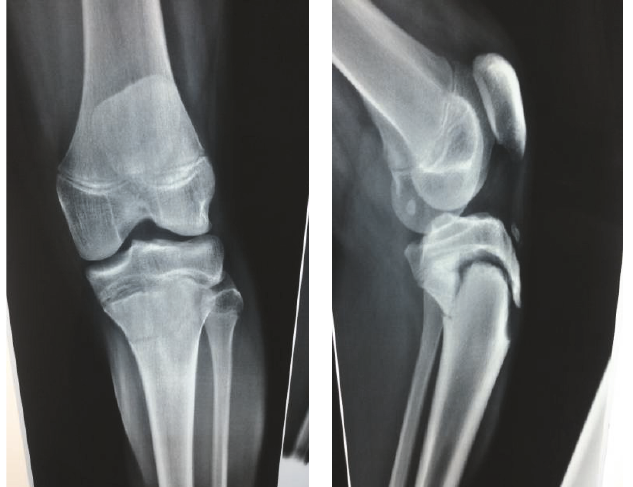
Figure 1: Initial injury.